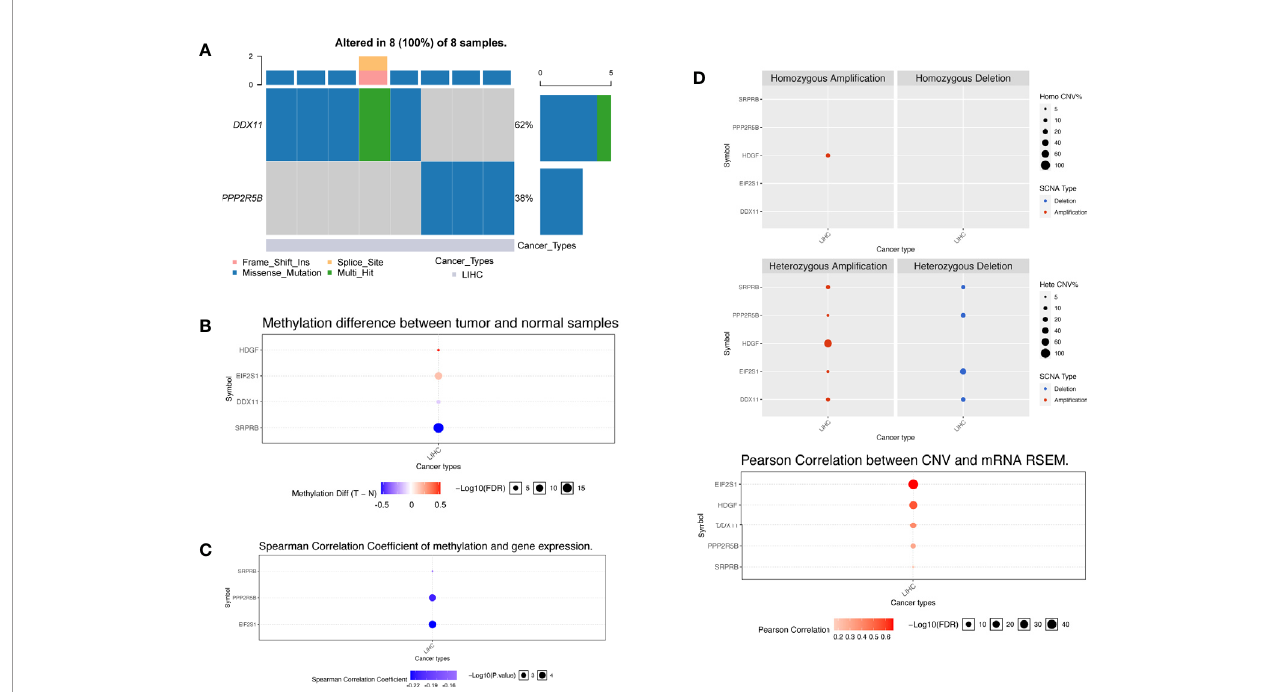
FIGURE 8 | Multi-omics analysis of fi ve gene signatures in TCGA cohort by GSCALite. (A) In the oncoplot graph, different color represents different types of variation. (B) Methylation difference between tumor and normal samples. (C) Spearman correlation coef fi cient of methylation and gene expression. (D) Copy number variation pattern of 5 gene